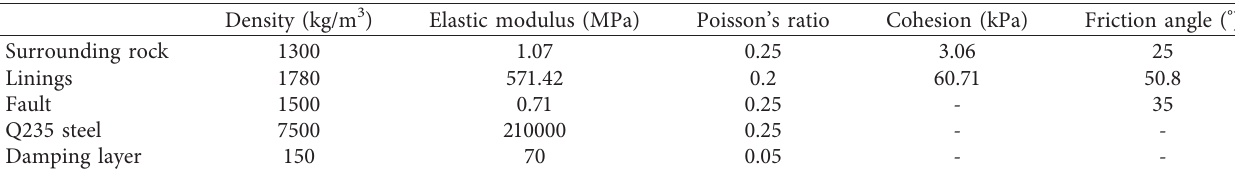
Figure 10: Computational model of the shaking table test. Table 6: Physical parameters of the